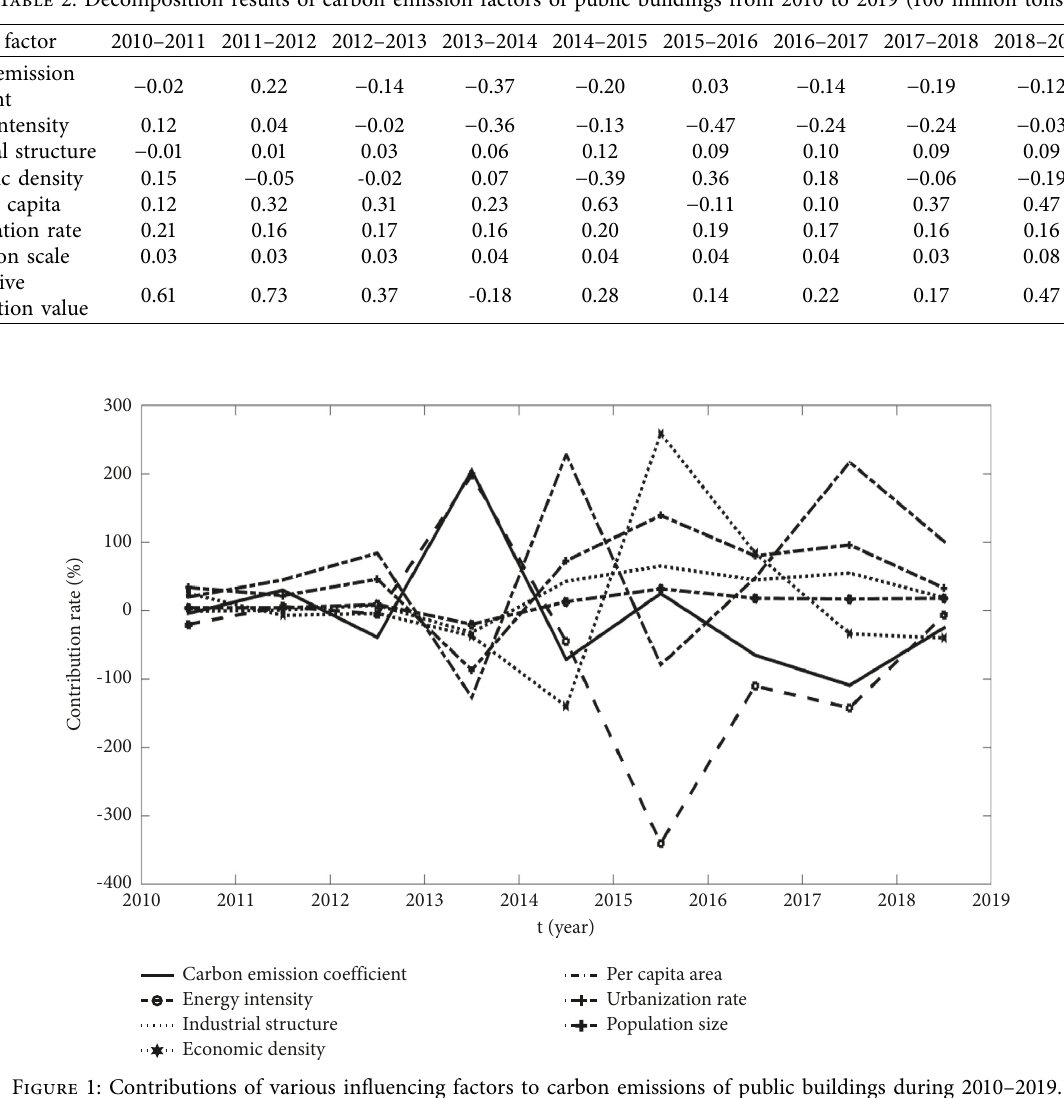
Table 2: Decomposition results of carbon emission factors of public buildings from 2010 to 2019 (100 million tons).